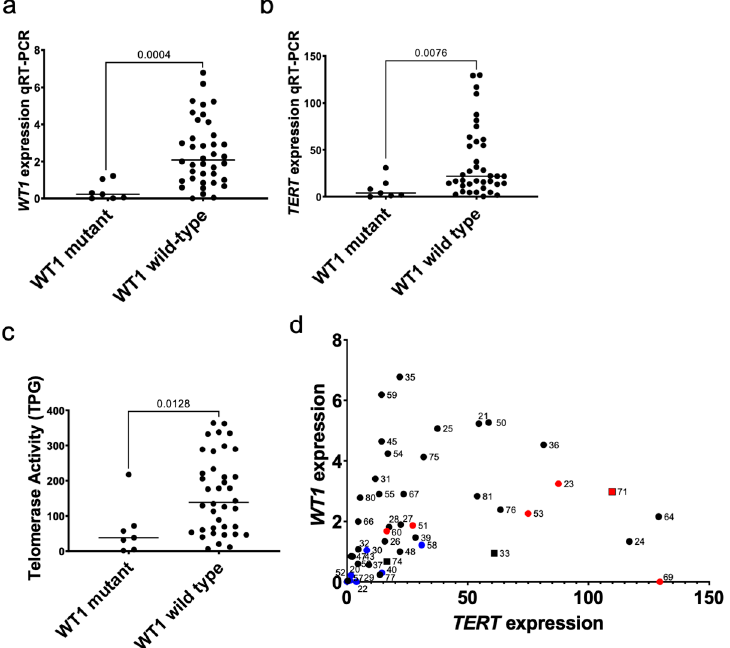
Figure 2. Relationship between biallelic inactivating mutations in WT1 and TERT expression. ( a ) The expression of WT1 was validated to be lower in specimens with biallelic inactivating mutations in WT1 compared to wild type specimens by qRT-PCR (Mann-Whitney p = 0.0004). ( b ) TERT expression is significantly lower in WT1 -mutant Wilms tumor patient-derived xenografts compared to wild type specimens by qRT-PCR ( p = 0.0076). ( c ) The telomerase repeat amplification protocol (TRAP) assay was quantified to calculate the total product generated (TPG) and WT1 -mutant specimens had significantly lower telomerase activity than WT1 -wild type specimens ( p = 0.0128). ( d ) A significant positive correlation between qRT-PCR quantification of WT1 and TERT levels (Spearman r = 0.47; p = 0.001) was detected. Blue = WT1 mutant xenografts, Red = anaplastic xenografts. Squares = xenografts with TERT promoter mutations. Circles = xenografts without TERT promoter muta- tions.